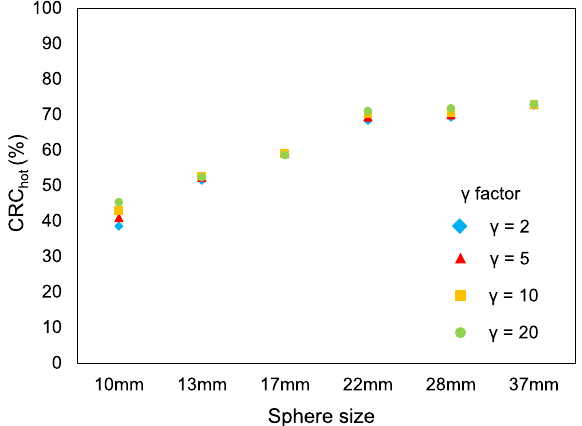
Fig. 5 Percent hot contrast recovery coefficient as a function of sphere size with different γ factors in images reconstructed using BPL and β =